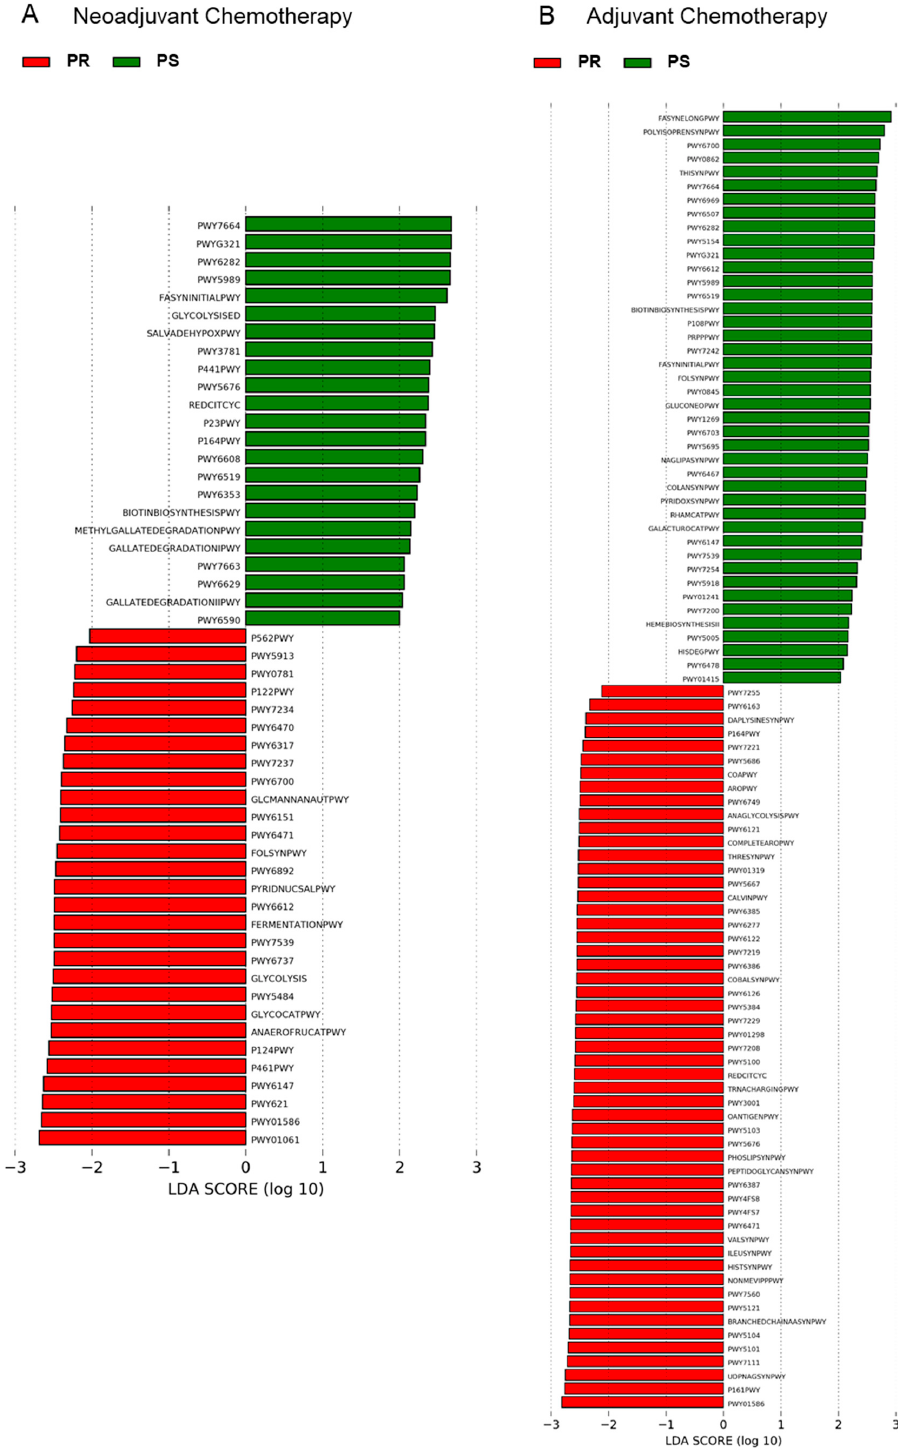
Figure 7. Potential inferred metagenomics signatures of therapeutic response in EOC patients receiving neoadjuvant or adjuvant chemotherapy. Differentially represented inferred functions between platinum-sensitive (i.e., PS) and platinum-resistant (i.e., PR) EOC patients receiving neoadjuvant ( A ) or adjuvant ( B ) chemotherapy were identified by linear discriminant analysis (LDA) effect size (LEfSe) analysis. The logarithmic threshold for discriminative features was set to 2.0. See also Table S1 for MetaCyc pathways and corresponding